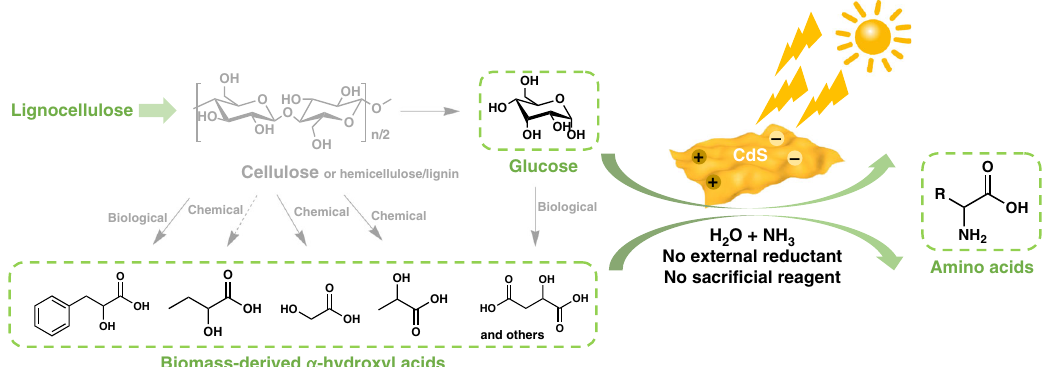
Fig. 1 Photocatalytic amination of glucose or biomass-derived α -hydroxyl acids to amino acids. Woody biomass components, including cellulose, hemicellulose, and lignin, could be converted into α -hydroxyl acids (left). In this work, these acids has been photo-catalytically converted into several important amino acids under visible-light irradiation over CdS nanosheets (right). Glucose is also converted into alanine in a